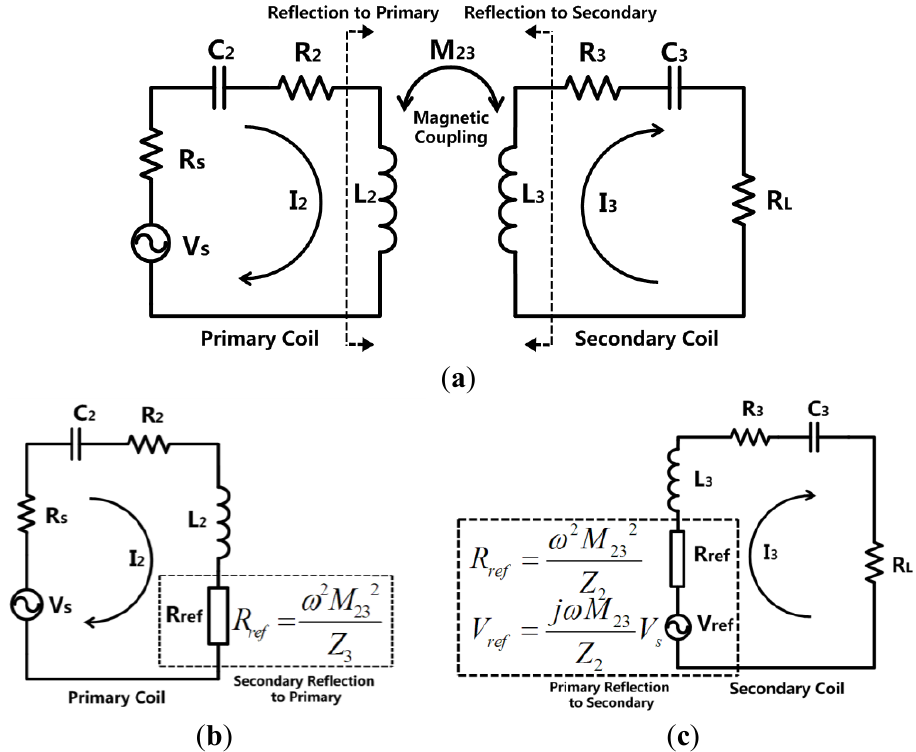
Figure 1. ( a ) Equivalent circuit model of system architecture with two coils; ( b ) simplified circuit model by making the secondary coil to be the equivalent impedance in the primary coil; ( c ) simplified circuit model by making the primary coil to be an equivalent voltage source and the equivalent impedance in the secondary